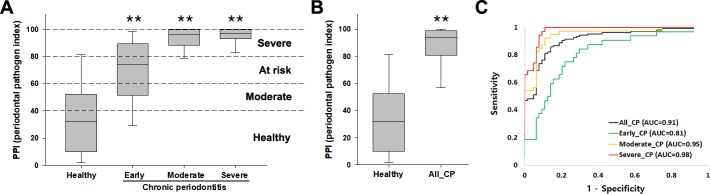
The PPI grading system applied to mouthwash samples from healthy subjects and chronic periodontitis patients.(A) The four categories of the PPI score according to cut-off values from ROC curve analysis. Whisker box plots indicate the distributions of scores in each group. (B) Comparison of PPI scores between healthy controls and all chronic periodontitis patients. (C) ROC curves for all, early, moderate, severe chronic periodontitis. **P < 0.0001 compared with healthy controls. All_CP: sum of early, moderate, and severe chronic periodontitis.